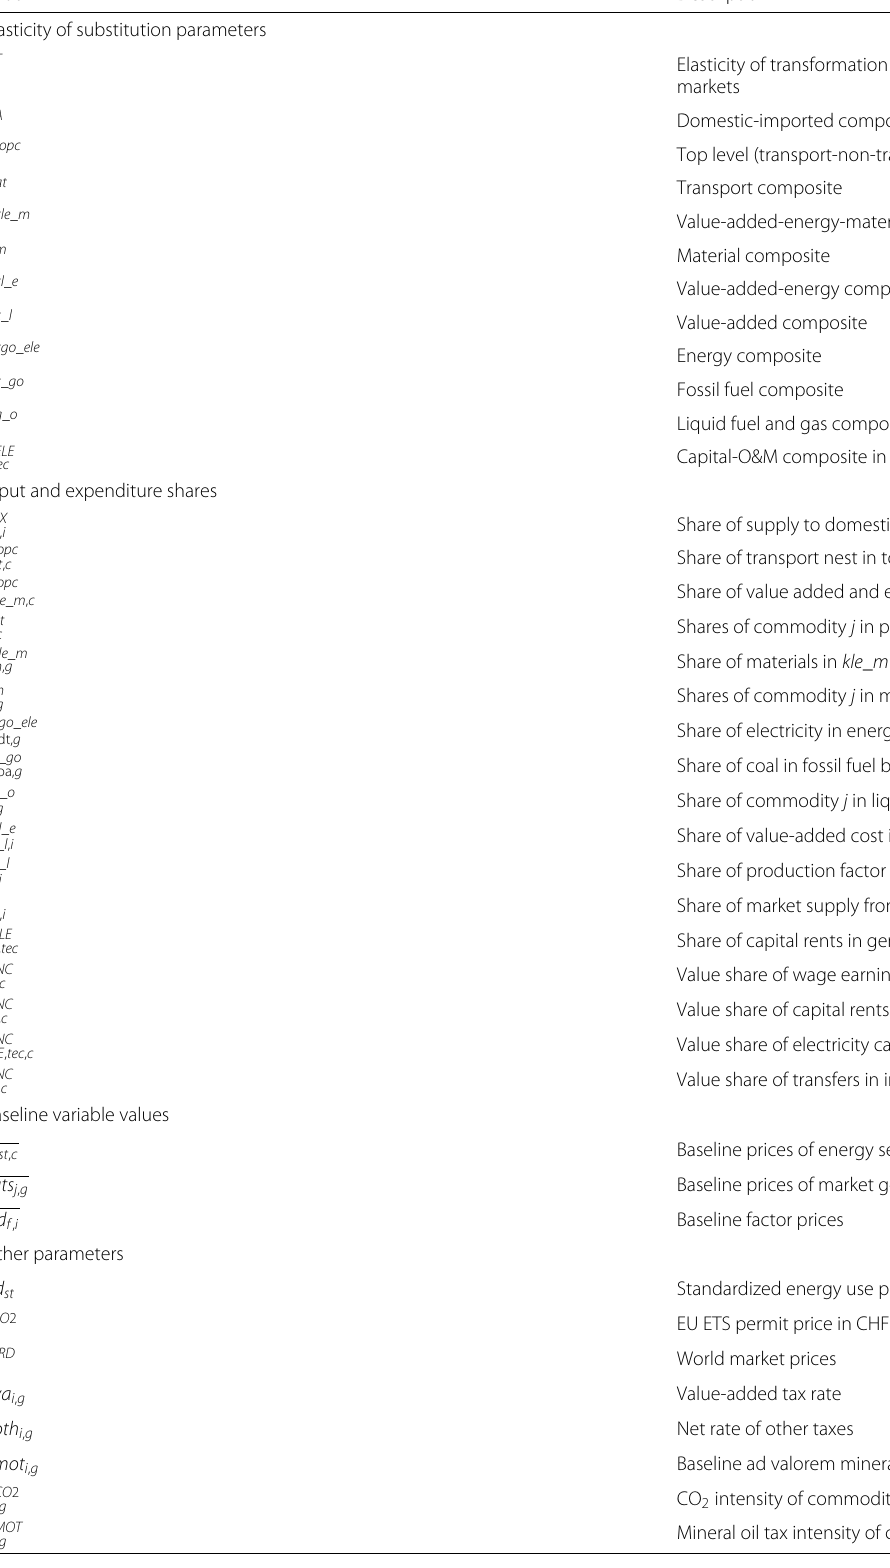
Table 15 Model parameters Symbol